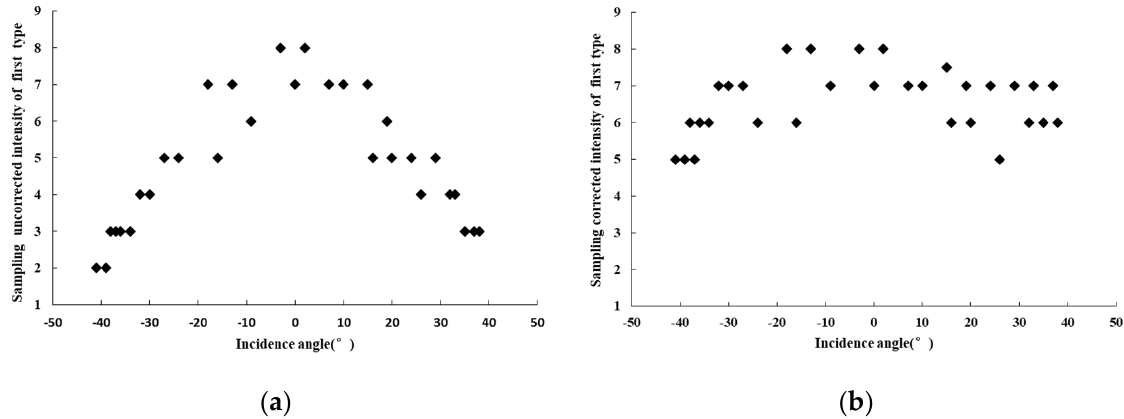
Figure 8. Results for strip 1: ( a ) the original intensity values (the amplitude); ( b ) the corrected intensity values by eliminating the effects of incident angle and range.